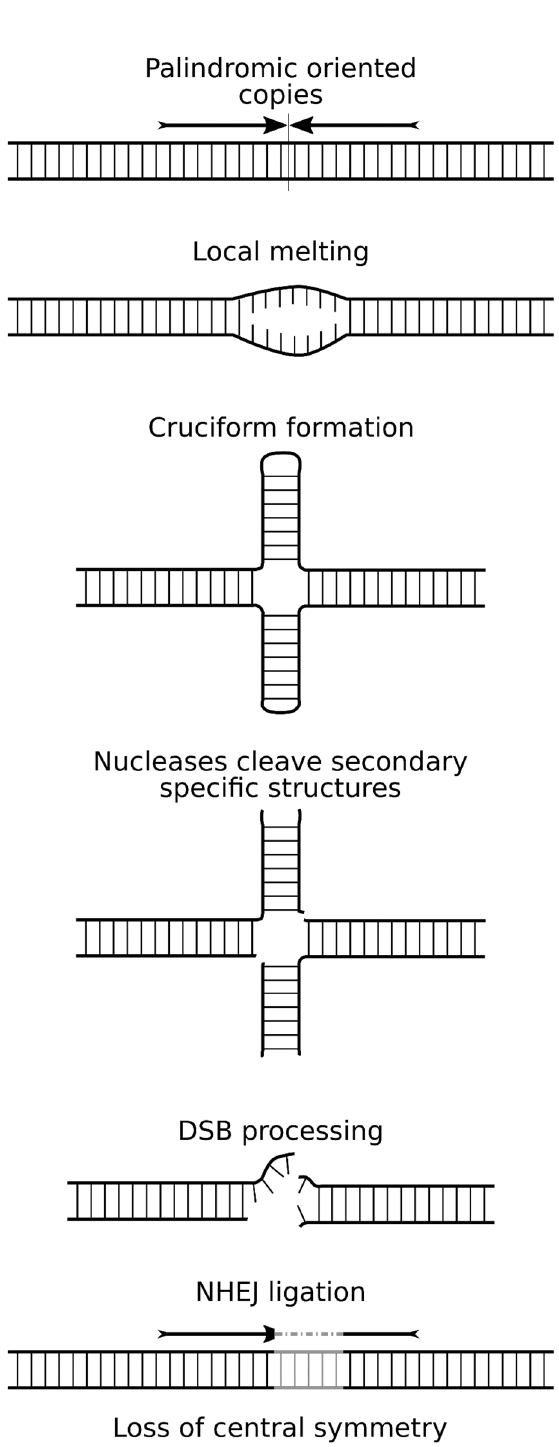
Figure 3. Cells stabilize palindromic junctions by introducing asymmetrical deletions. The general scheme of the appearance of cruciforms and their transformation into DSB. The reasons for denaturation can be different: torsion stress, replication, transcription, close DSB.